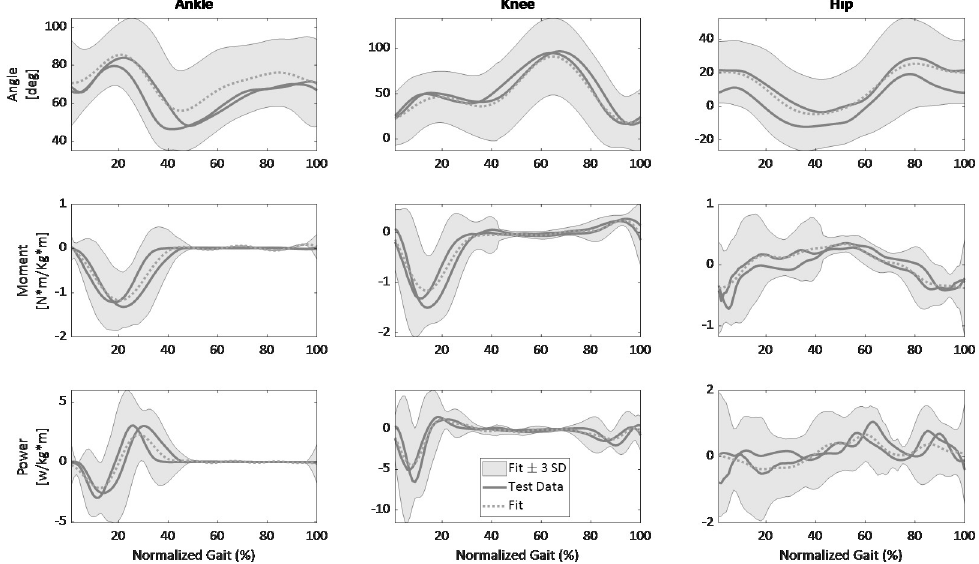
Fig 8. Comparison between the final fits and data on the sagittal plane from two participants not included in the model’s training, featuring lower-limb joint variables for running at a -10% surface gradient as a function of stride cycle percentage (0% is heel strike) compared with experimental data. The dotted line represents fit, and the gray line represents the two test participants’ average cycle data. The gray shading is the between- participants variability represented with three standard